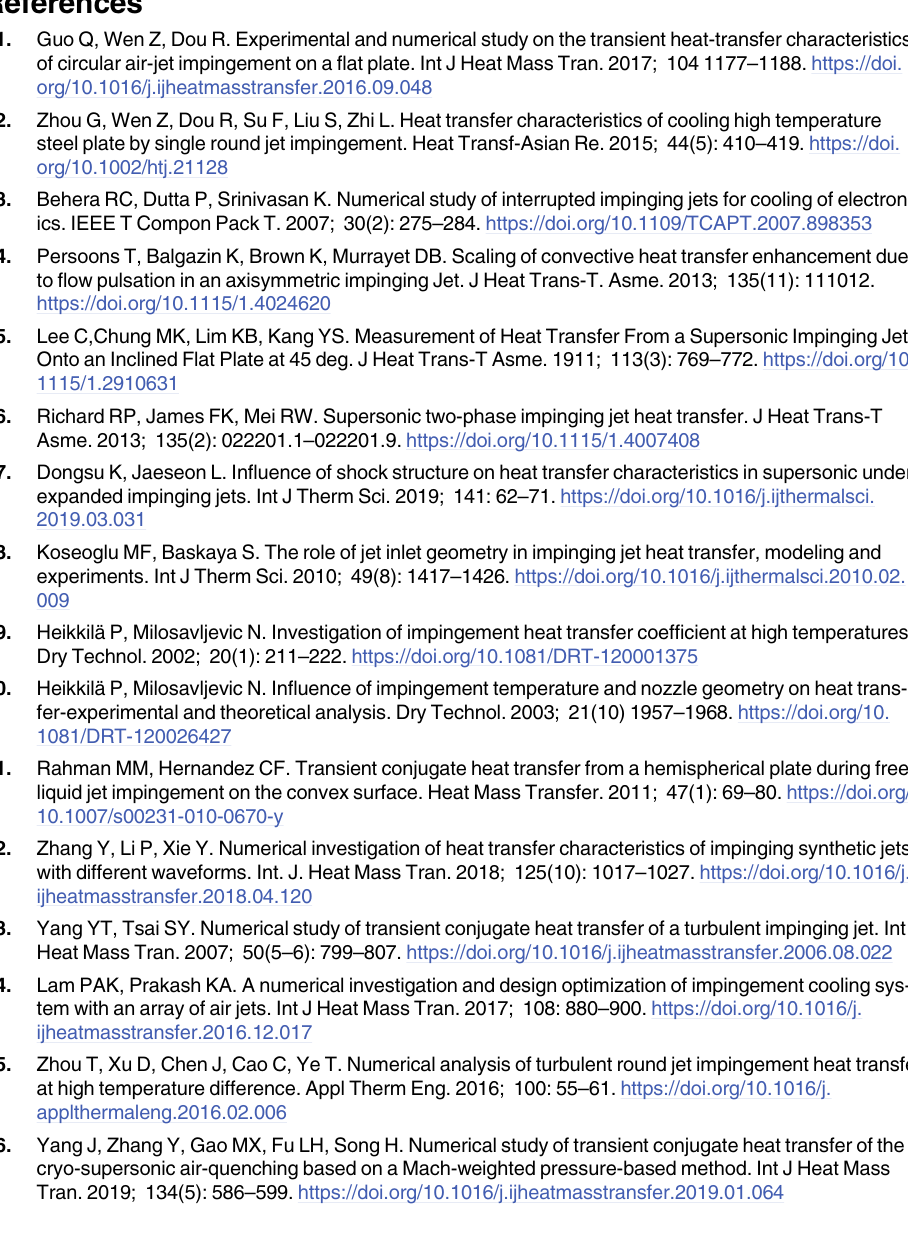
S1 Table. The coefficients of Eq (8) at H/D = 3, 4, and